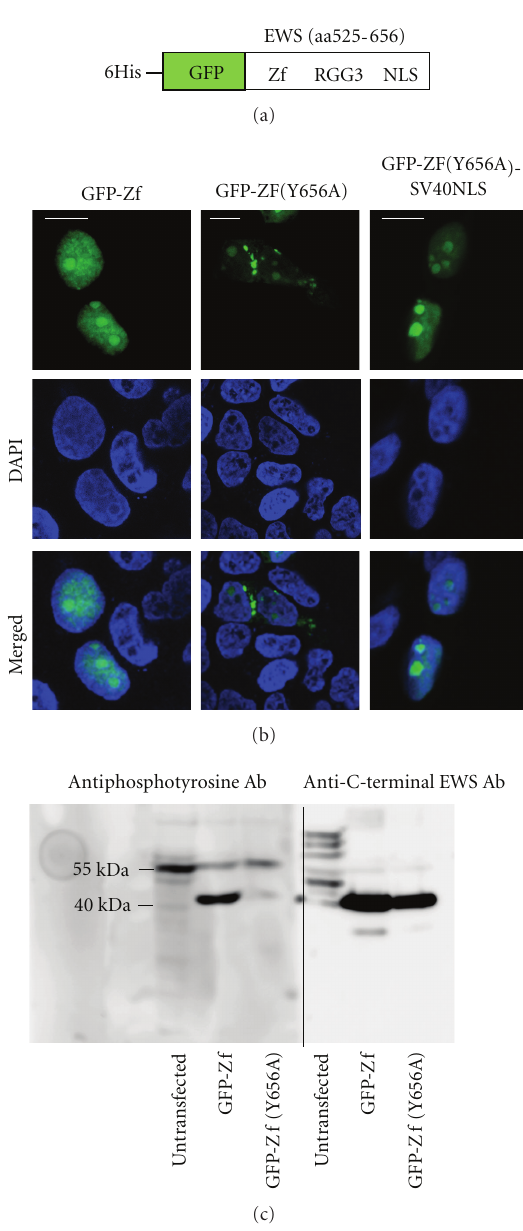
Figure 2: (a) Schematic representation of the N-terminally tagged GFP-Zf fusion protein. 6His-GFP is fused to the EWS mutant protein (aa 525–656). (b) Representative examples of the subcellular localization (all cells expressing the construct are showing the indicated localization) of GFP-Zf, GFP-Zf(Y656A), and GFP- Zf(Y656A)-SV40NLS (in green). Nuclei are shown by DAPI staining (in blue). Bars, 15 μ m. (c) Phosphorylation analysis of GFP-Zf and GFP-Zf(Y656A) using antiphosphotyrosine antibodies. GFP-Zf and GFP-Zf(Y656A) fusion protein bands are detectable at ∼ 40 kDa. The additional phosphorylated protein band detected at ∼ 55 kDa was identified as p54nrb.